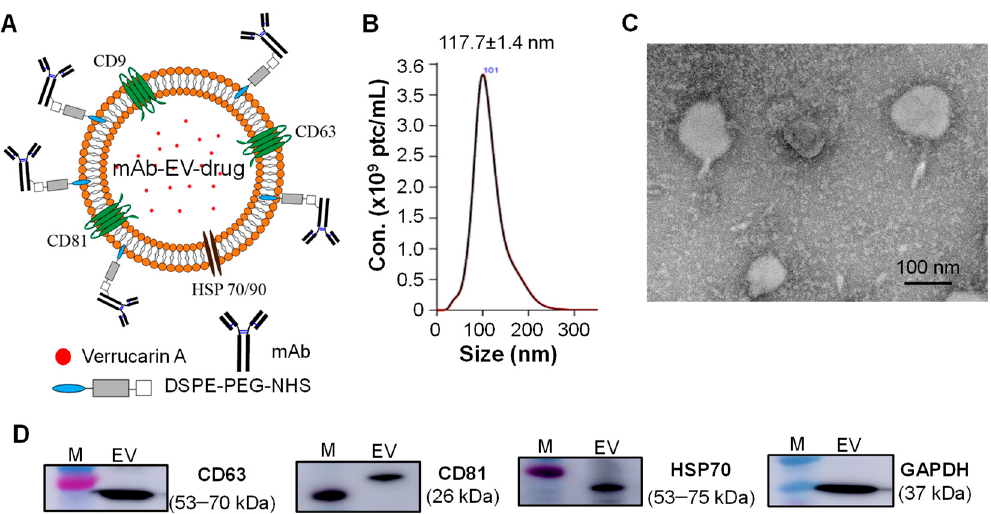
Figure 2. Characterization of mAb-EV-drug. ( A ) Construction and structure of mAb-EV-Ver-A: mAb was surface tagged on EV via DSPE-PEG-NHS and payload Ver-A was packed in EV. ( B ) Size distribution by NanoSight assay. ( C ) TEM image of mAb-EV-Ver-A. Scale bar equals 100 nm. ( D ) Western blotting analysis of EV biomarkers (CD63, CD81, HSP70, and